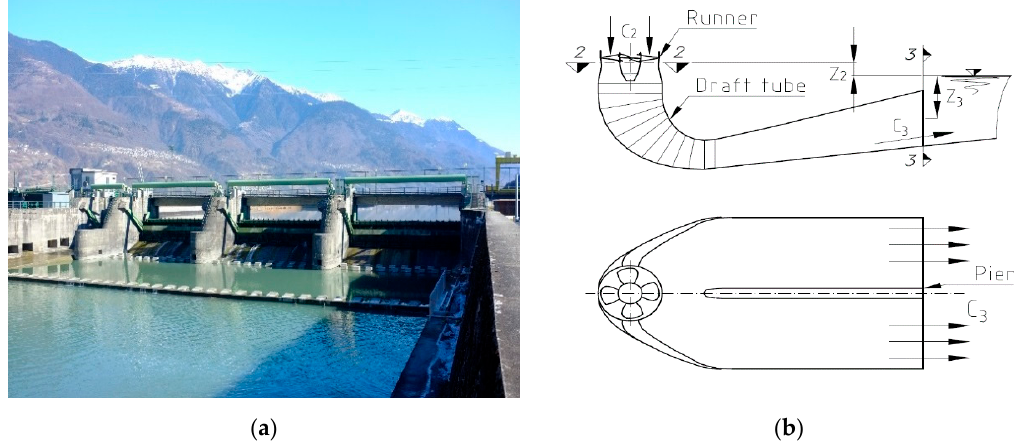
Figure 1. Original power plant: ( a ) overall external view; ( b ) baseline elbow-draft tube geometry.